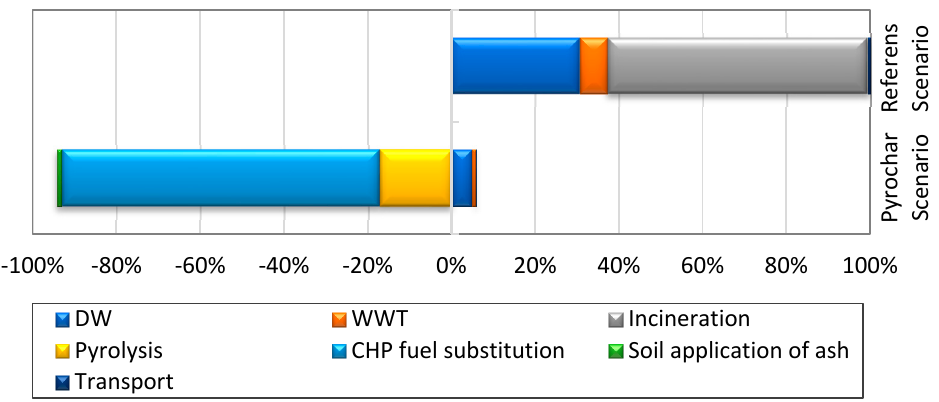
Figure 4. The GHG contribution analysis of various processes in Reference Scenario and Pyrochar Scenario indicated in percentage. The WWT and DW represent wastewater treatment, dewatering processes respectively.